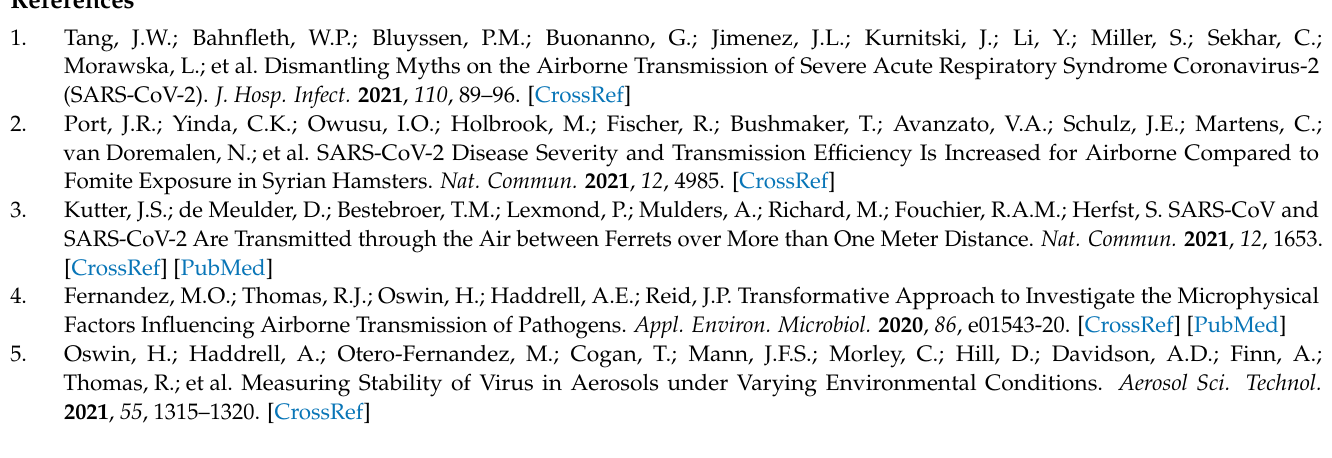
surements form Figure 3. Table S3. Measurements from Figure 4. Table S4. Standardised distribution of T = 0 descriptive statistics. Figure S1. Qualitative evidence for efflorescence. Figure S2. Standardised distribution of T = 0. Figure S3. Bulk liquid viral infectivity at high pH, comparing two concentrations of FBS. Figure S4. Effect of mucin on bulk phase infectivity and evaporation kinetics. Figure S5. SEM micrographs of particles collected from the bottom of